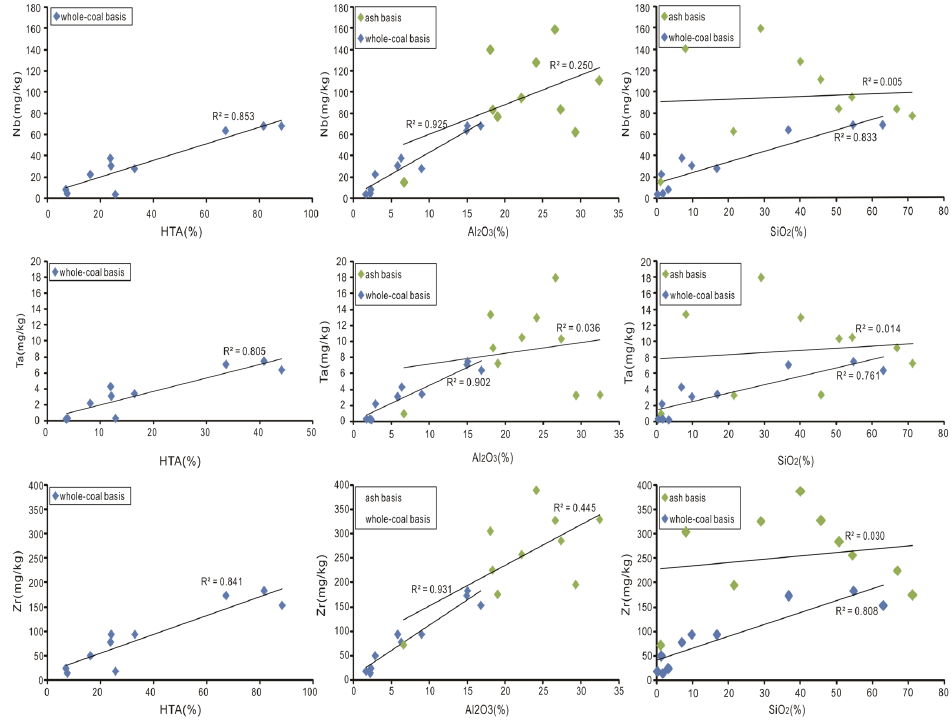
Figure 10. Relations between concentrations of Ta, Nb, and ZrwithHTA yield (whole-coal basis), Al 2 O 3 (whole-coal and ash basis), and SiO 2 (whole-coal and ash basis) contents in the Jinhuashan coals. Based on Al 2 O 3 -TiO 2 plots, Zr/TiO 2 -Nb/Y plots, REE-Y distribution patterns, as well as Eu and